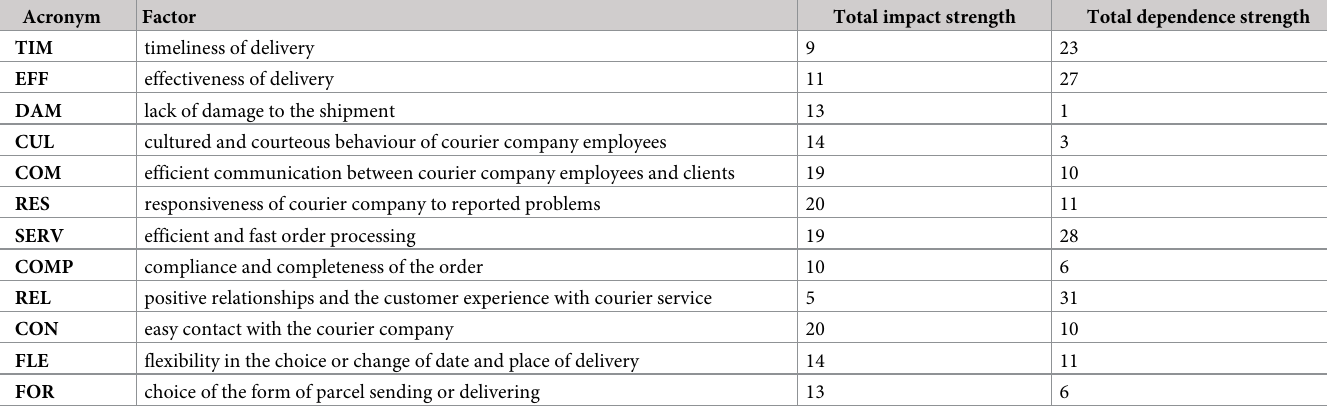
Table 4. Summary of direct interaction strengths between factors in the structural